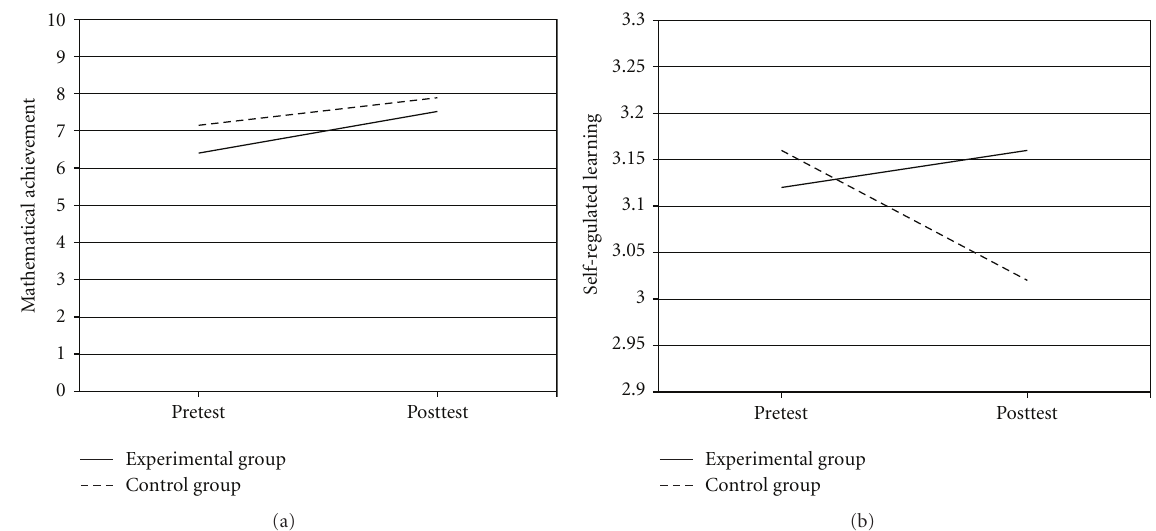
Figure 2: Interaction time × group for the overall scale self-regulated learning as well as for mathematical achievement. Mathematical achievement measures could take values from 0 to 10; self-regulated learning was rated on a four-point